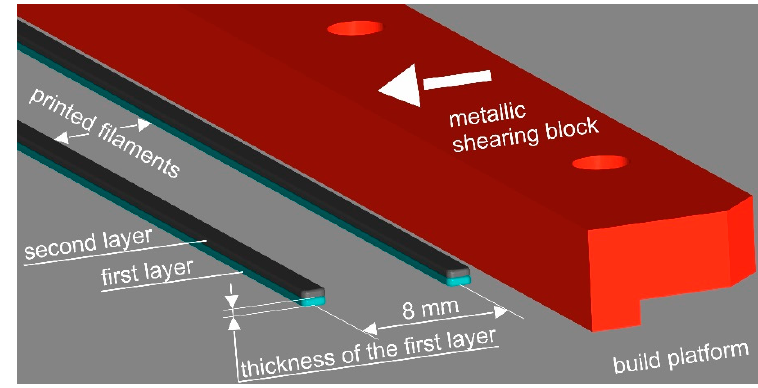
Figure 1. Schematic representation of the shear-off testing mechanism of the printed filaments by a metallic shearing block, along with a description of the most important expressions used throughout the manuscript. The arrow on the metallic shearing block symbolises its horizontal movement that causes the detachment of the filaments from the build platform.